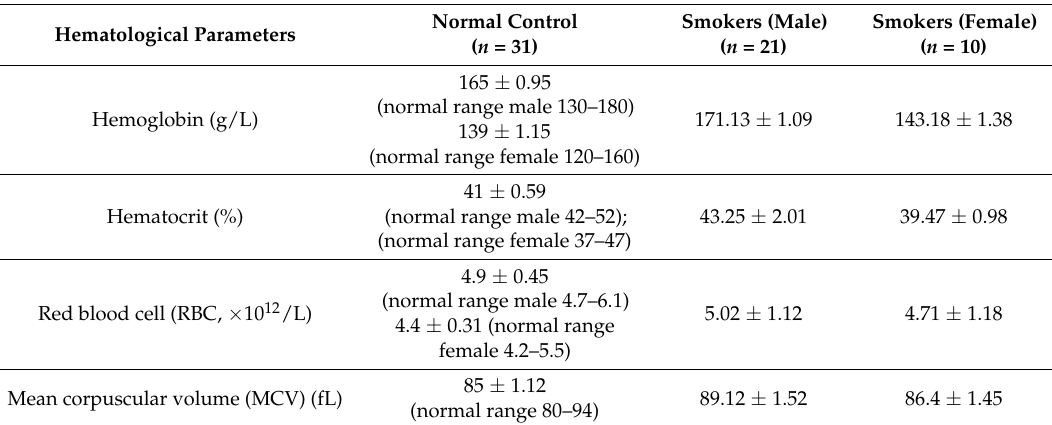
Table 2. Statistical analyses of demographic and laboratory value of data of normal control, smokers (male), and smokers